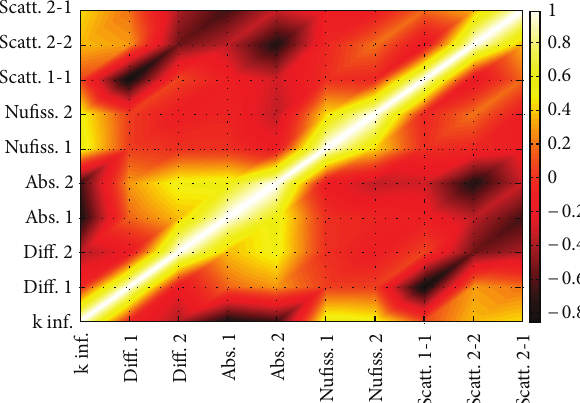
F 14: Correlation matrix of the output parameters based on ENDF/B-VII.1